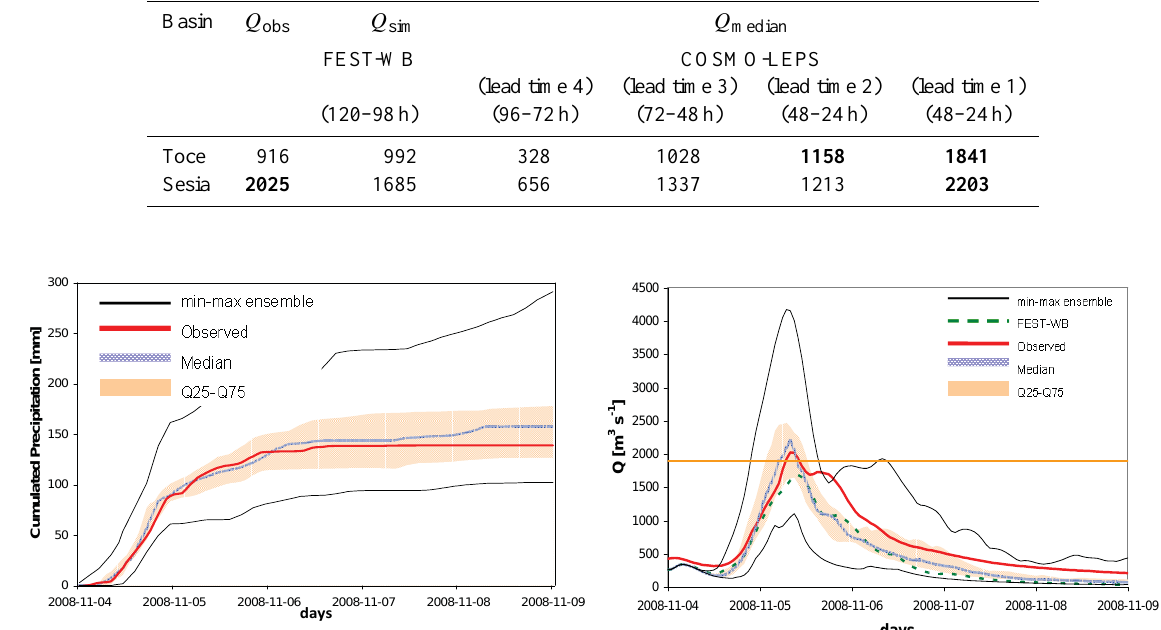
Fig. 3. Quantitative precipitation forecast, QPF, (left) of the COSMO-LEPS model in comparison to the mean cumulative observed precip- itation (red line) over the Sesia Basin; the purple line shows the COSMO-LEPS median precipitation, the light orange shadows show the COSMO-LEPS 25th and 75th percentile precipitation and the black lines refer to the COSMO-LEPS envelope precipitation. The run started on 4 November 2008. QDF (right) of the FEST-WB model forced with observed data (green dashed line) and COSMO-LEPS meteorological data. In particular, the red line shows the observed discharge at Palestro, the purple line shows the ensemble median discharge, the light orange shadows show the ensemble 25th and 75th percentile discharge and the black lines refer to the ensemble envelope discharge. The run started on 4 November 2008. The horizontal orange line is the warning code 2 for the Sesia Basin.